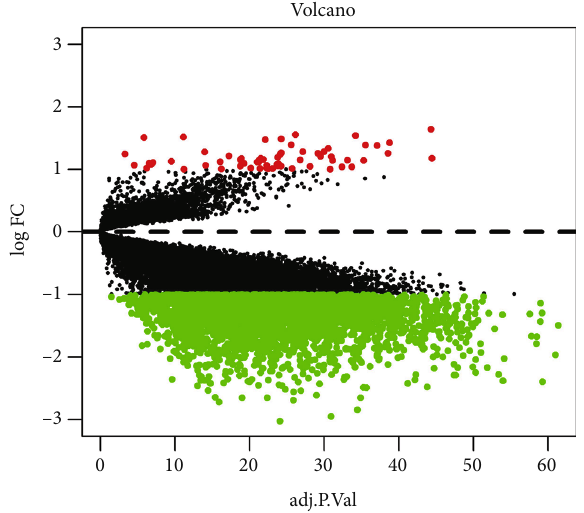
Figure 2: The volcano plot shows the DEGs. The red dots represent up-regulated genes, the green dots represent down- regulated genes, but the black dots represent genes that are non- signi fi cantly di ff erentially